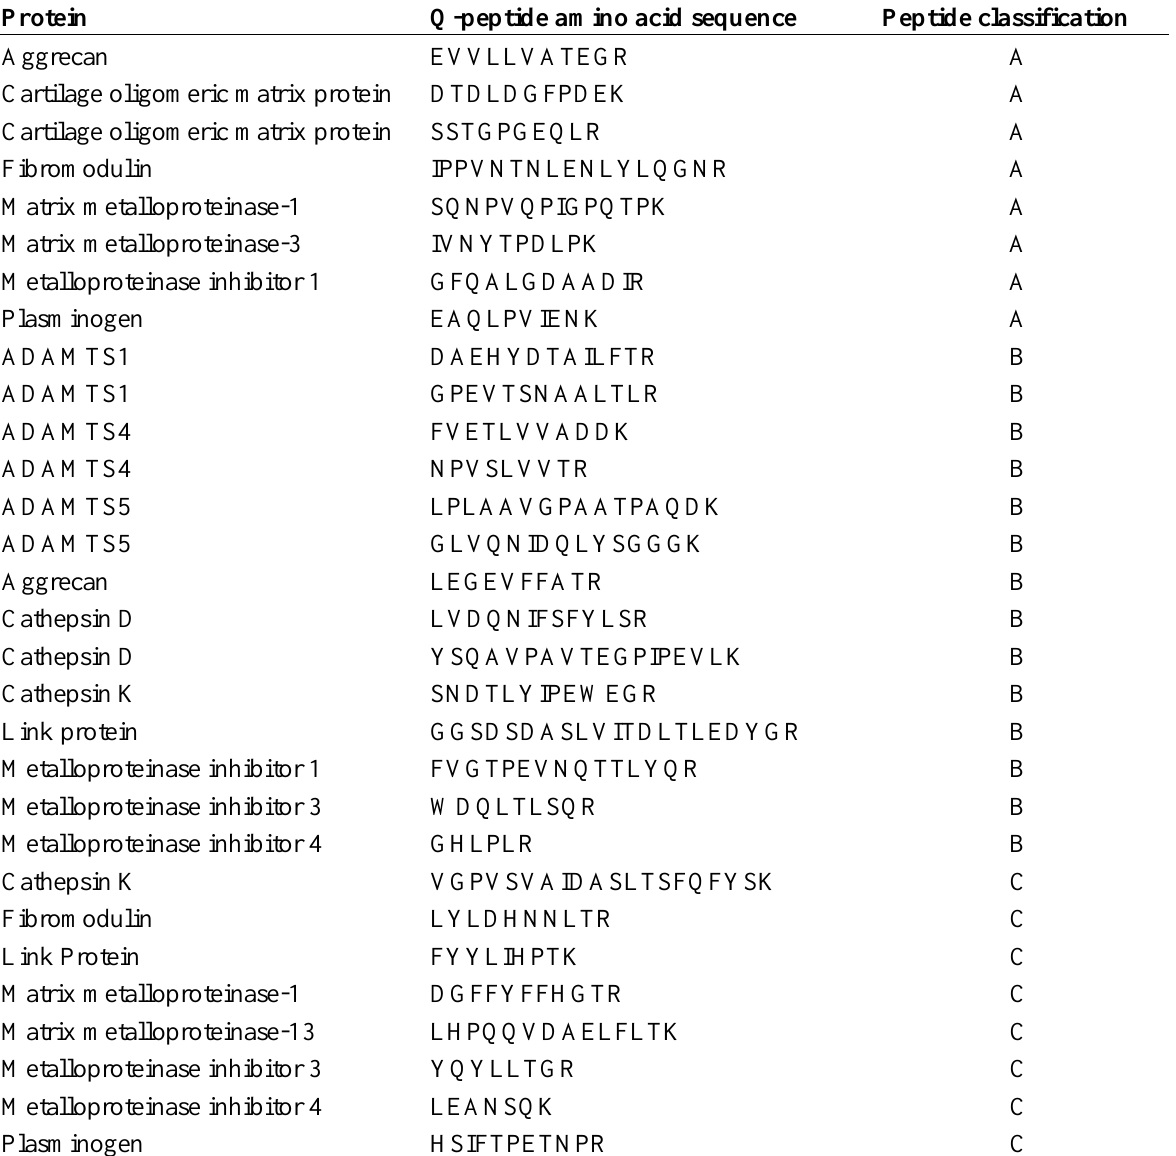
Table 2. Represents peptide types as determined by SRM experiments. Q-peptides are classified for quantification purposes as A, B, C. “Type A” native and QconCAT peptides are detected. “Type B” are peptides detected for the QconCAT but not in native form and when neither QconCAT nor native peptides are detected a “Type C” classification is given (ADAMTS; A disintegrin and metalloproteinase with thrombospondin